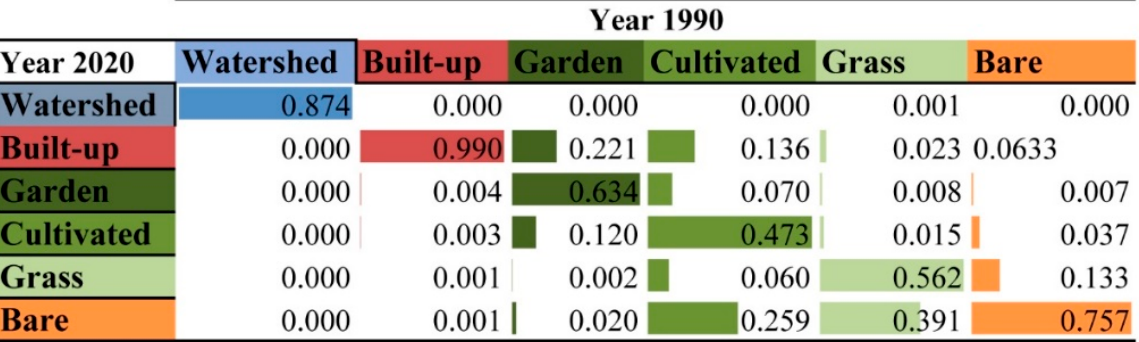
Figure 7. Transition probability matrix.